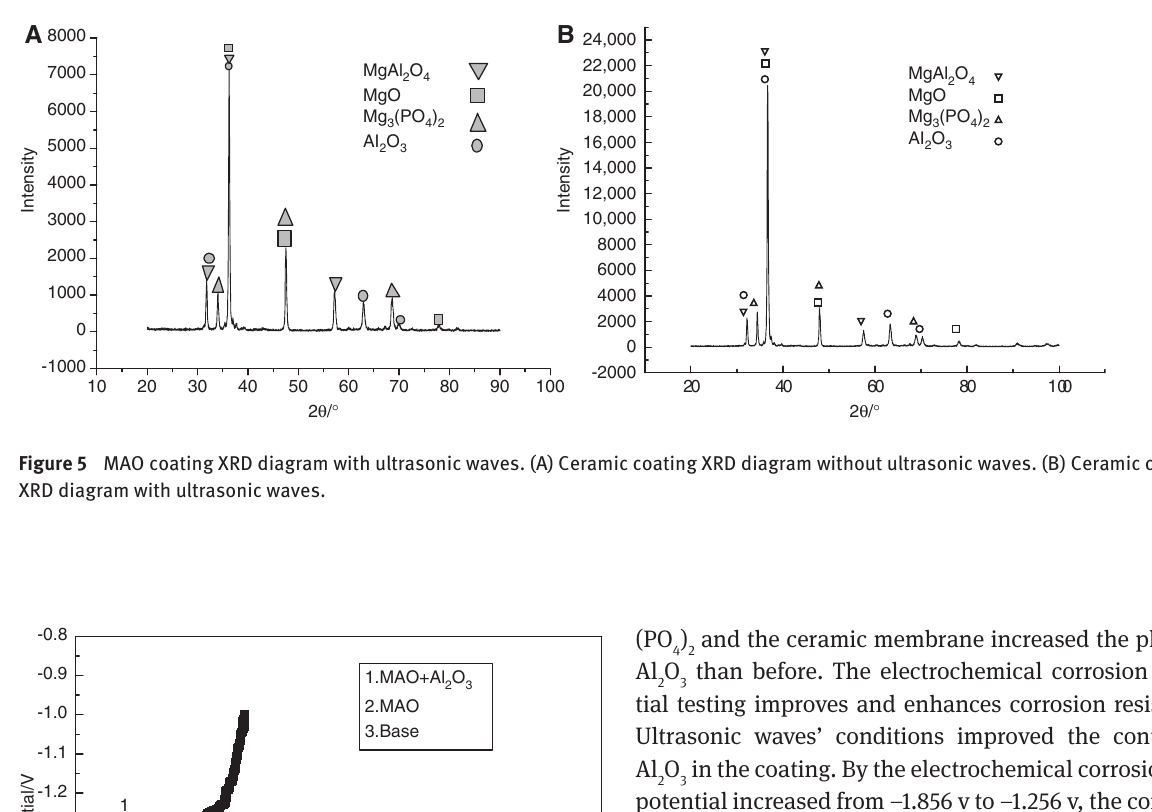
Figure 4 MAO coating XRD diagram. (A) Ceramic membrane pre-accession XRD diagram without Al Al O XRD diagram. 2 3